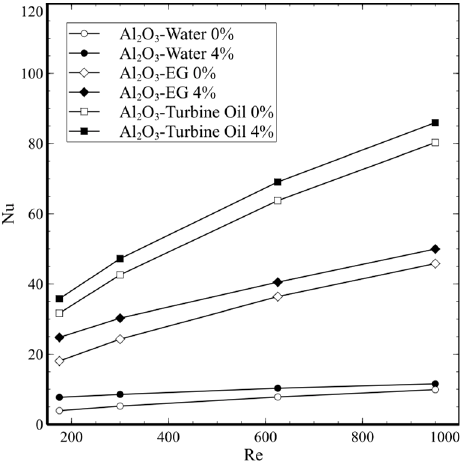
Figure 7. Comparison of Nu for Al 2 O 3 -water, Al 2 O 3 -EG and Al 2 O 3 -turbine oil at 𝜙 (cid:3029) = 4%.